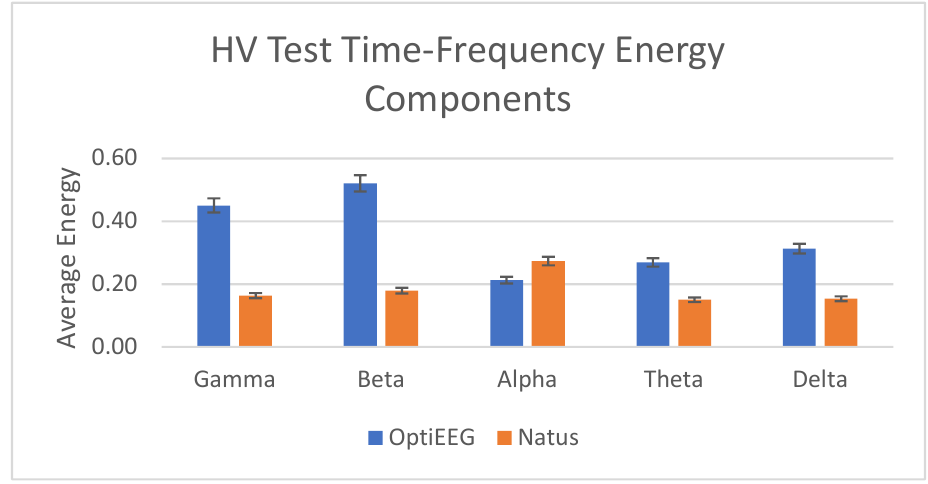
Figure 14. Power of time–frequency components for HV test. The next common activation technique used in a routine EEG is PS. PS induces photic drive, a rhythmic frequency in the occipital derivations that consists of harmonically related activity to the flickering light [61]. Photic driving involves synchronization of the occipital alpha rhythm with the stimulus frequency [60]. The study also used this test to verify the capacity of OptiEEG response towards capturing the photic rhythmic response from Natus, as in Figure